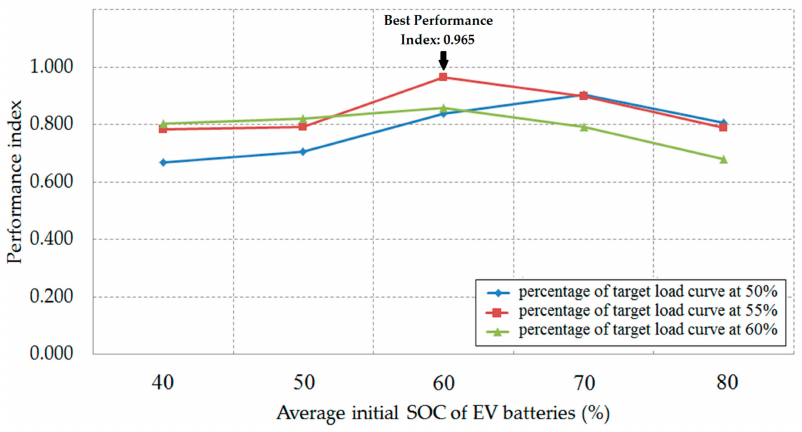
Figure 10. Overall Performance Index under various